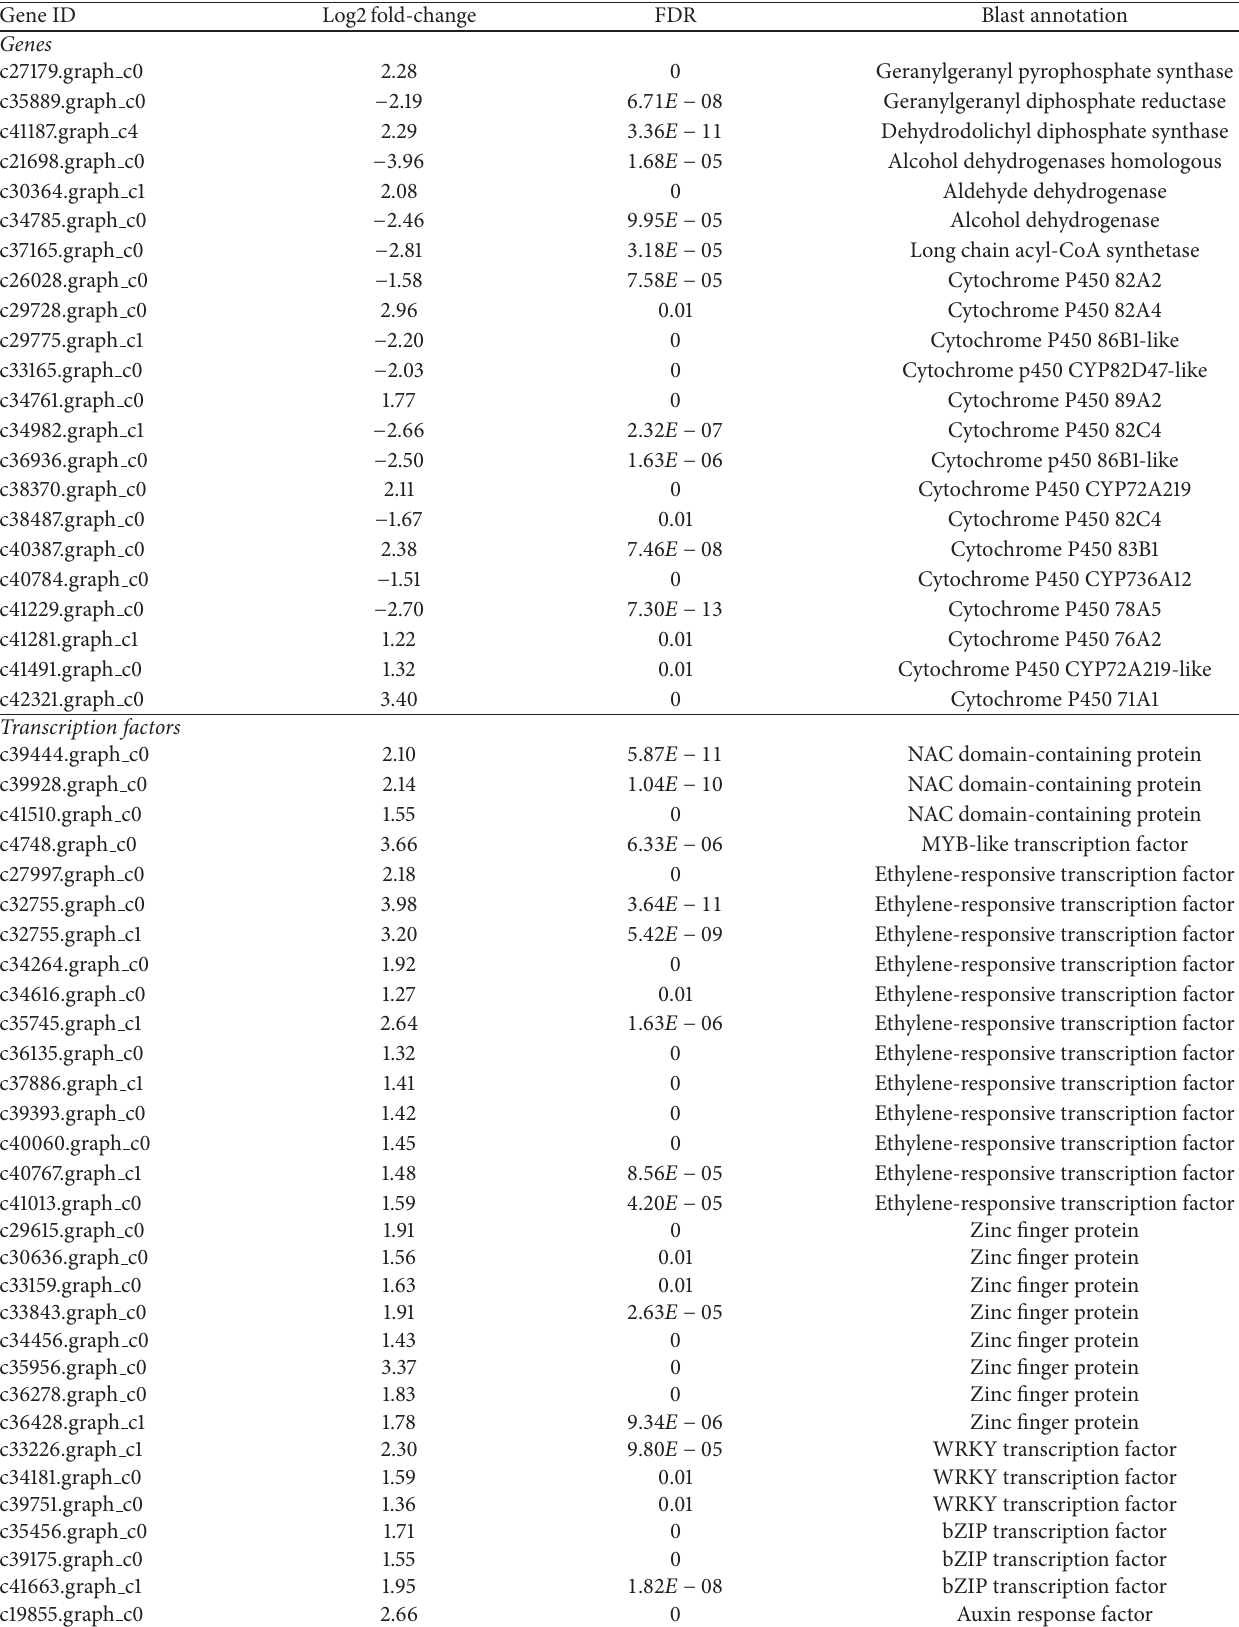
Table 3: Differentially expressed genes and transcription factors related to carotenoid biosynthesis between Weiduoli and